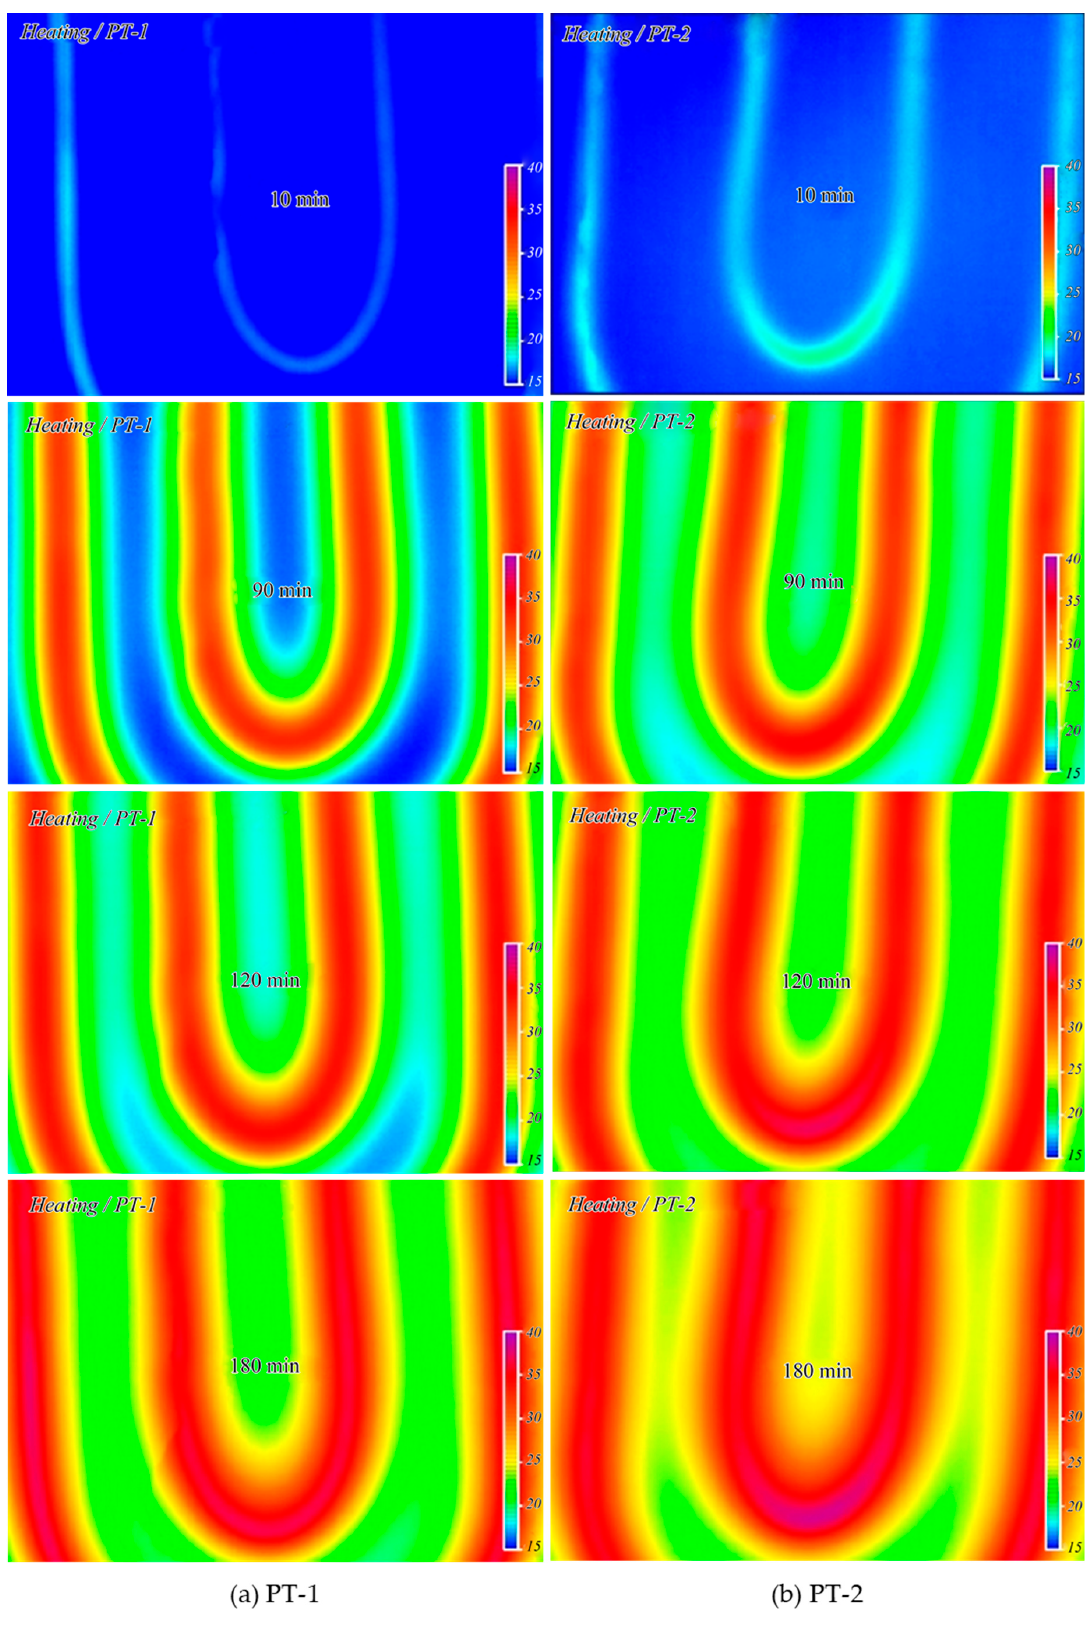
Figure 13. Temperature change of heat storage layer (heating cycles).